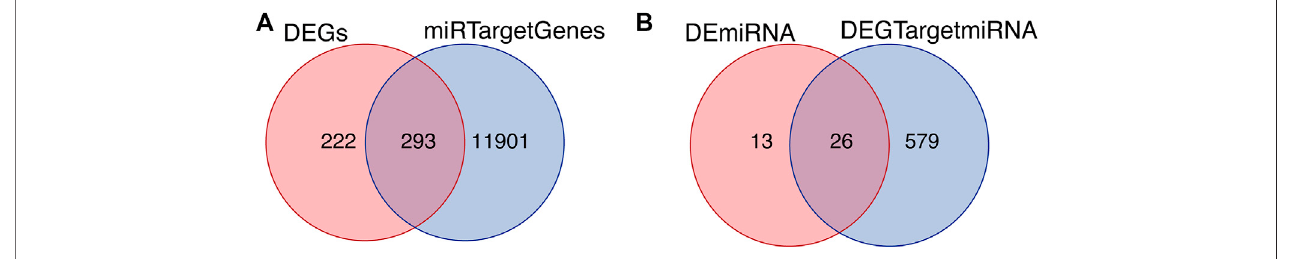
FIGURE4| Intersected differentially expressed genes and target genes. (A) Theintersection ofDEGs and miRNA target genes. (B) The intersection of differentially expressed miRNAs and target miRNAs of